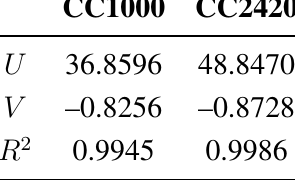
p V to the real values of g ( p tx ·